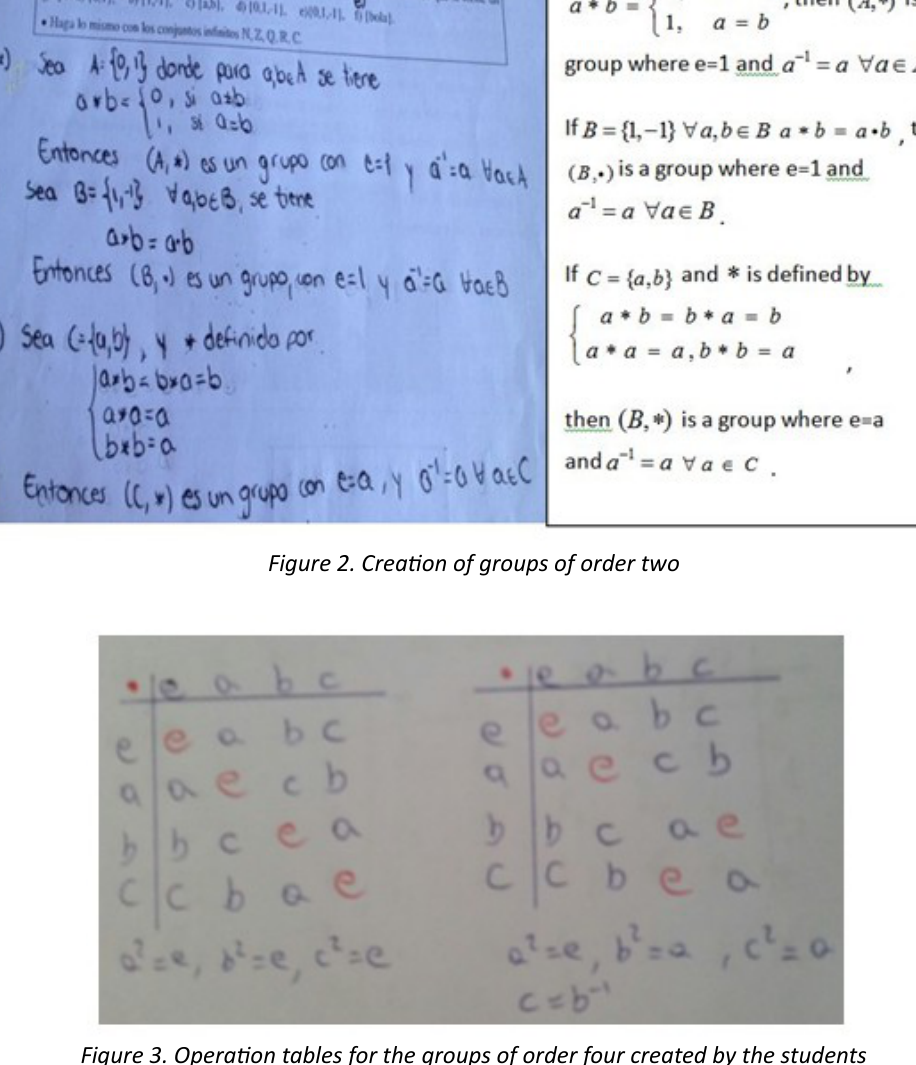
Figure 3. Operaton tables for the groups of order four created by the students